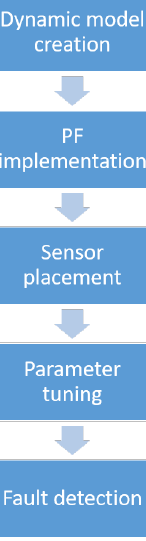
Figure 2. Outline of the main steps of the proposed method. The proposed approach covers the tasks from the creation of the dynamic model through the implementation of the PF to its application in fault